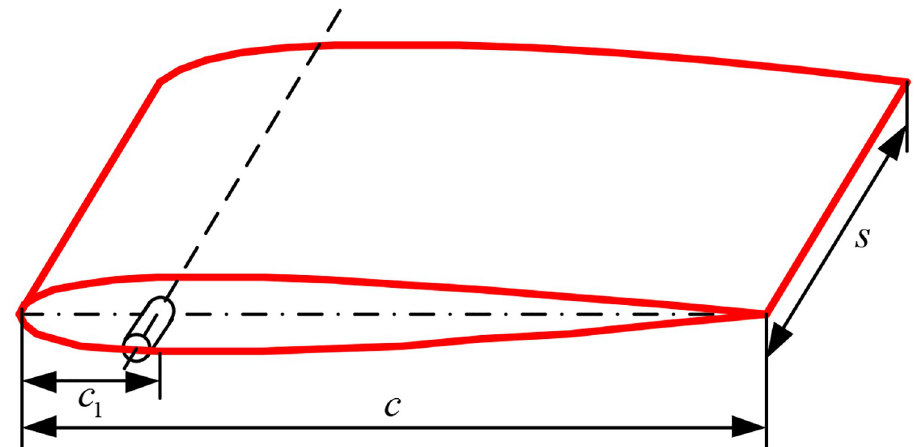
Fig 1. Prototype model of zero-speed fin stabilizer.